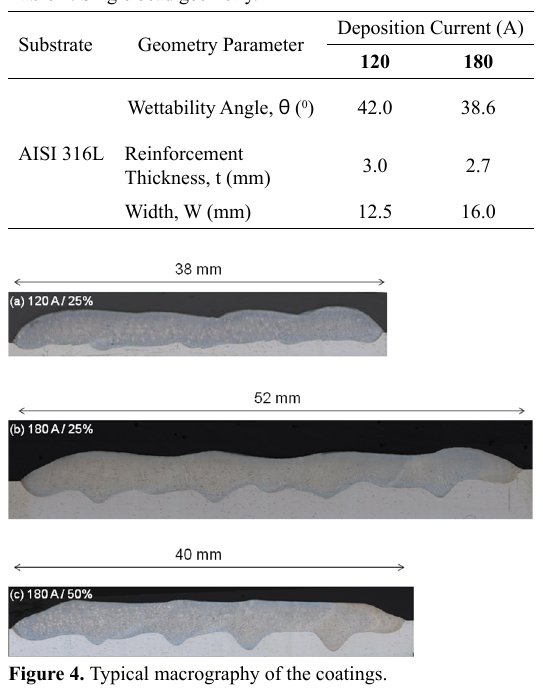
Table 4. Single bead geometry.